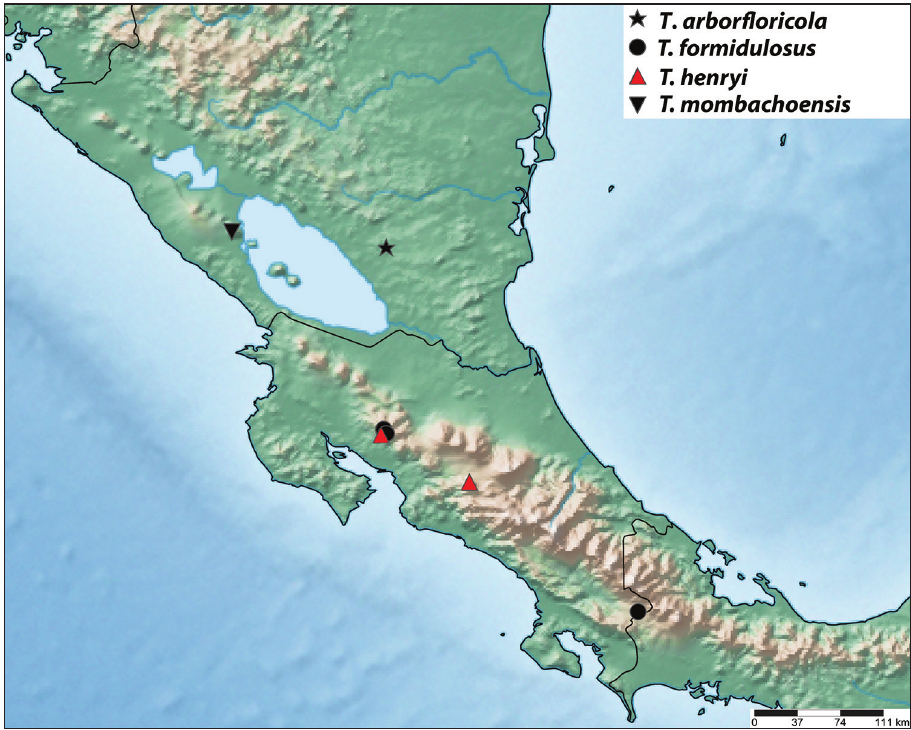
Figure 56. Distribution map in Nicaragua and Costa Rica for Trigonopeltastes arborfloricola sp. n. (  ), T . formidulosus sp. n. (  ), T . henryi sp. n. (  ), and T . mombachoensis sp. n. ( 